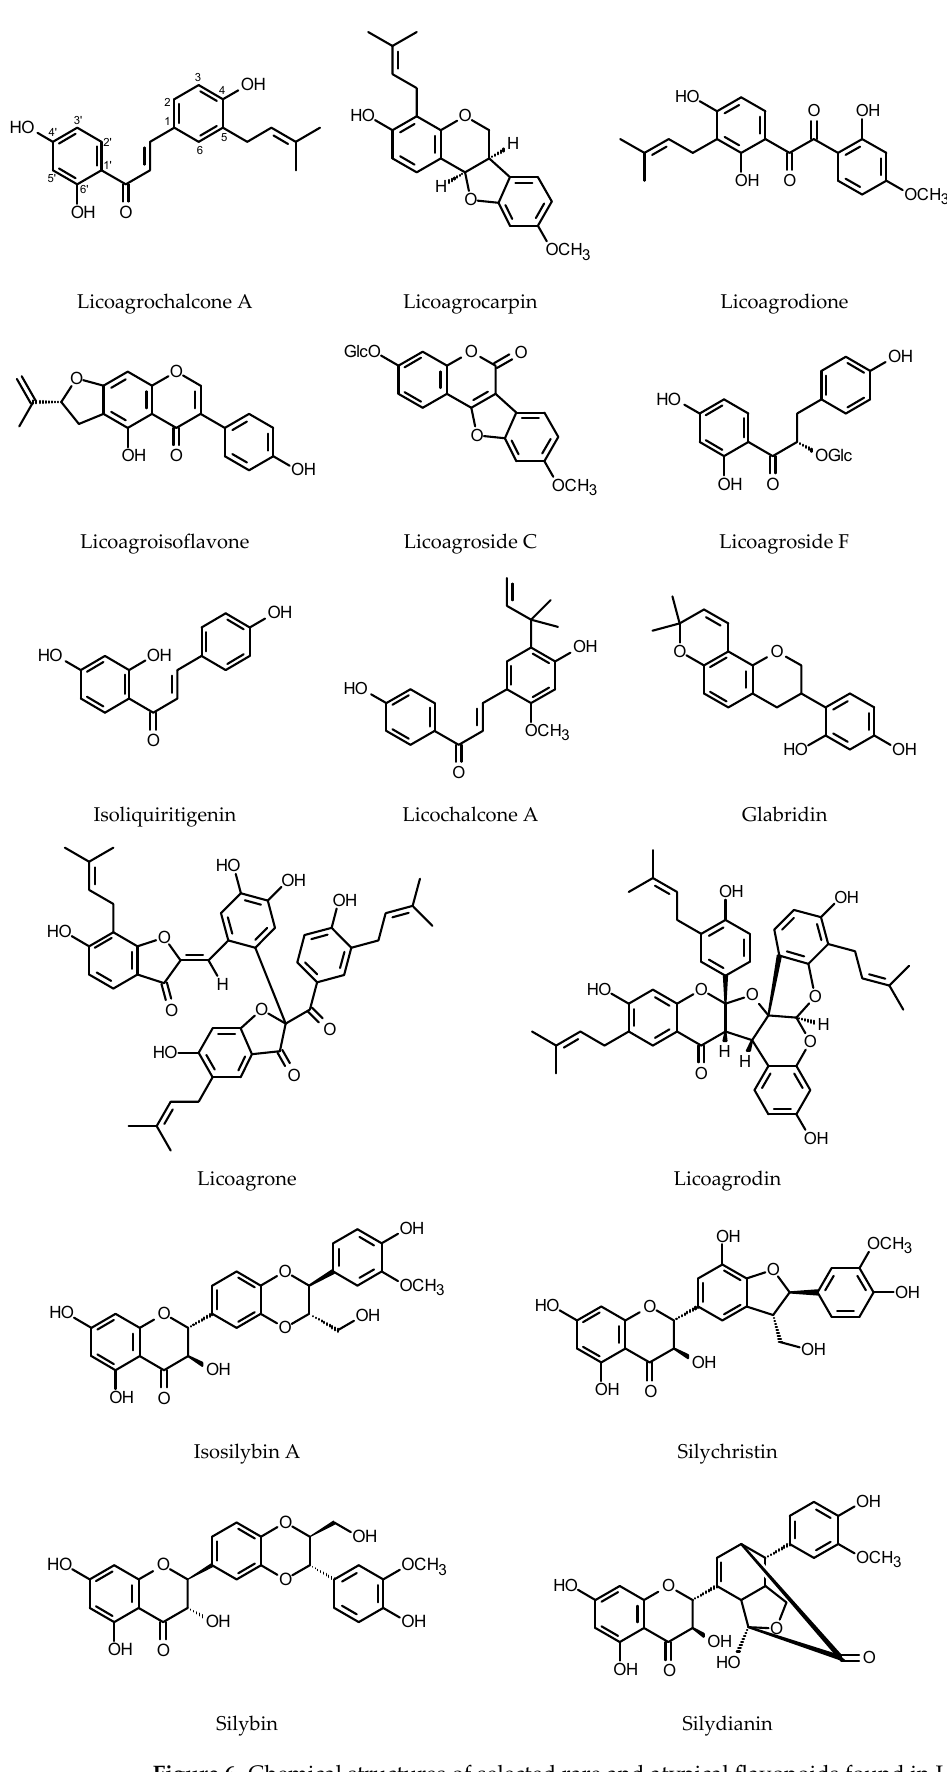
Figure 6. Chemical structures of selected rare and atypical flavonoids found in HRs. The Genista tinctoria L. HRs synthesized neither isoflavone, derivatives of daidzein and genistein, nor the derivatives of apigenin and luteolin characteristic of the intact plant. Instead, the roots accumulated isoliquiritigenin (daidzein precursor, 23 mg/g DW) absent from the roots of the intact plant. Abscisic acid (ABA, 37.8 µM), added to the culture on the 42nd day of growth, induced the release of the product (80%) to the culture medium [182]. Alikaridis et al. [183] investigated roots obtained by a transformation of Silybum mari- anum Gaertner with R. rhizogenes ATCC 15834. The roots contained only minute amounts (0.4 µg/g DW) of silychristin and silydianin. Silybins A and B were not detected, whereas the contents of isosilybins A and B were higher than those in the untransformed roots (isosilybin A—0.01 mg/g DW). The S. marianum HRs examined by Rahnama et al. [184] contained up to 0.14 mg/g DW silychristin. The other flavonolignans were present in smaller amounts. 2.2. Stilbenoids Stilbenoids are a class of polyphenolic plant constituents that have the general struc- tural formula C6-C2-C6 and share an initial part of their biosynthetic pathway with flavo- noids. The compounds could be found in various plant species, including peanut (Faba- ceae), grapevine (Vitaceae), berries (Ericaceae), pine (Pinaceae) and tomato (Solanaceae). Their main function is the protection of the host plant against pathogen infestation and oxidative stress generated by different environmental stimuli [185]. Stilbenoids, due to their biological activity, may find application as protective agents in cardiovascular dis- ease, diabetes, neurodegeneration, obesity and other ailments [186]. The compounds were primarily detected in elicited HRs and the procedures used to enhance the productivity of the cultured roots included elicitation (MeJa, paraqat, H 2 O 2 ) with concomitant use of permeabilizing agent (methyl- β -cyclodextrin) to liberate the products into the culture medium. R2R3-MYB-type transcription factors are engaged in the up-regulation of stilbenoid biosynthesis, and this may find an application in genetic engineering.